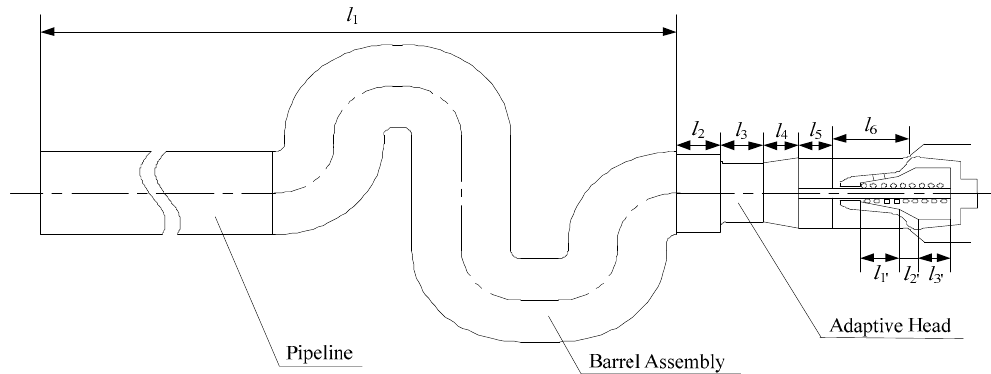
Figure 3. Structure of a fire-fighting jet system with the adaptive gun head.